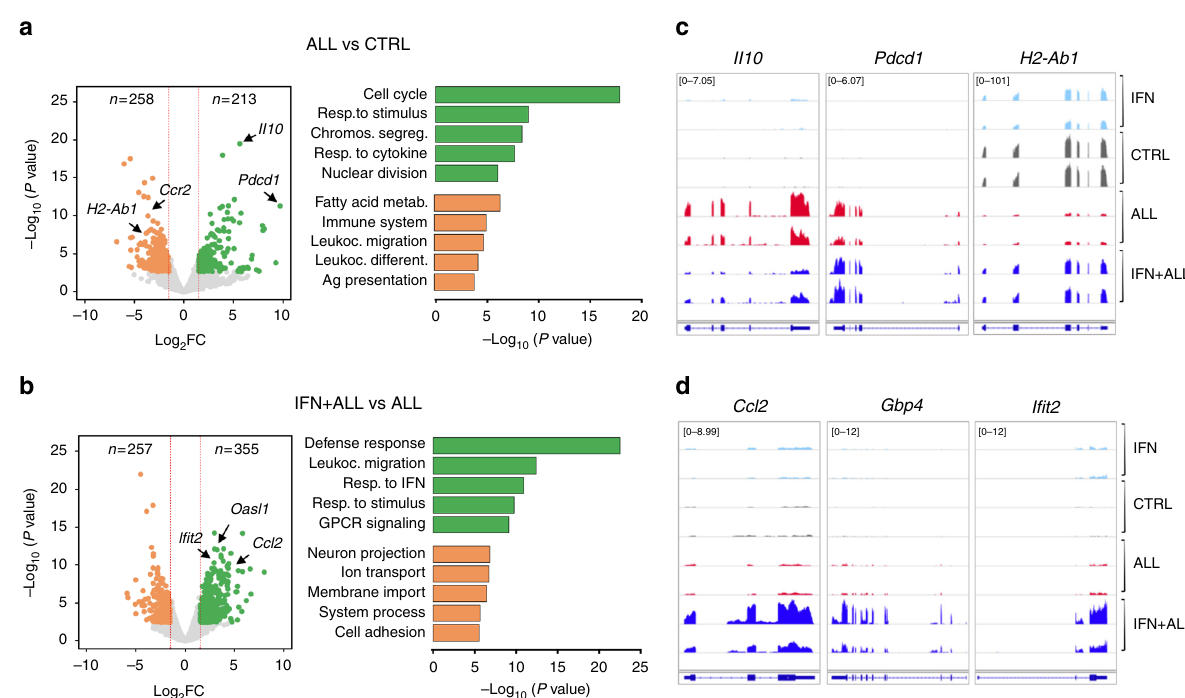
Fig. 4 Transcriptional reprogramming of tumor-associated macrophages by IFN gene therapy. a , b Volcano plots (left panels) showing differentially expressed genes (abs. log 2 FC > 1.5, FDR < 0.05) up-regulated (green) or down-regulated (orange) in splenic macrophages from tumor-bearing (ALL) vs. control (CTRL) mice ( a ) or ALL mice treated (IFN + ALL) or not (ALL) with IFN gene therapy ( b ). Bar plots (right panel) show GO terms enriched in up- regulated (green) or down-regulated (orange) genes from the indicated comparisons. c , d Selected RNA-Seq snapshots of deregulated genes in macrophages from ALL mice ( c ) or ISGs induced in IFN + ALL mice ( d